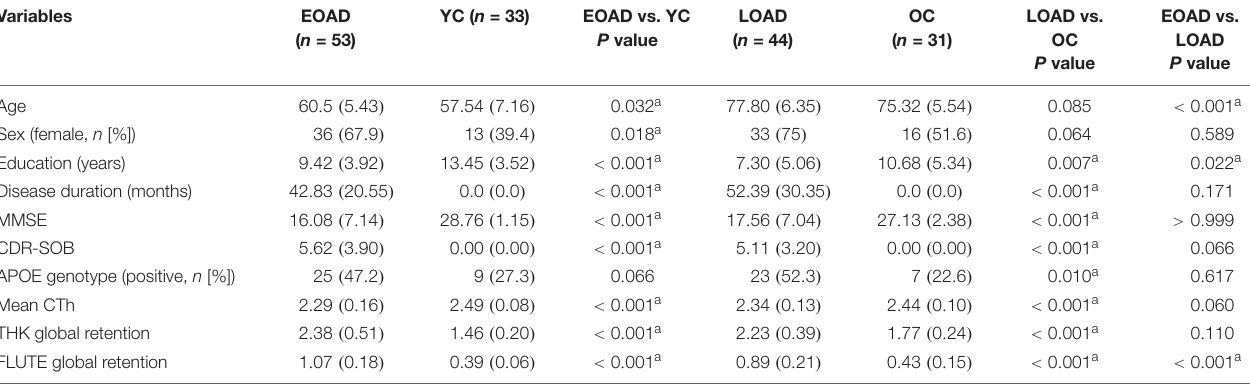
TABLE 1 | Demographics and clinical characteristics of the study population.